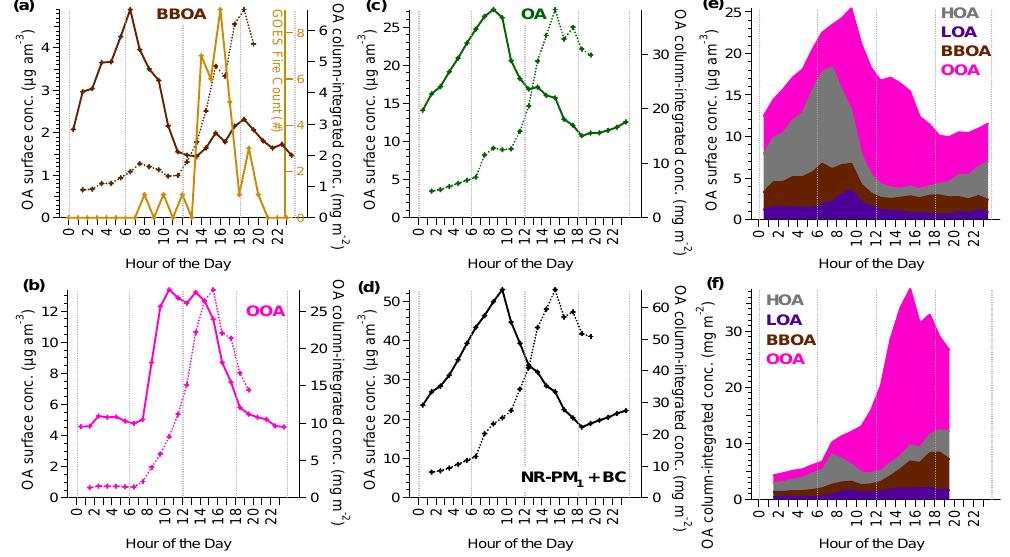
Figure 15. (a)-(d): diurnal profiles of the concentrations (solid) and estimated column-integrated amounts (dashed) for BBOA, OOA, OA, and NR-PM 1 +BC, column amounts are in mg m -2 ; (e) stacked plot of the diurnal cycles of the concentrations of the OA components; (f) stacked plot of the diurnal cycles of the estimated column amounts of the OA components.